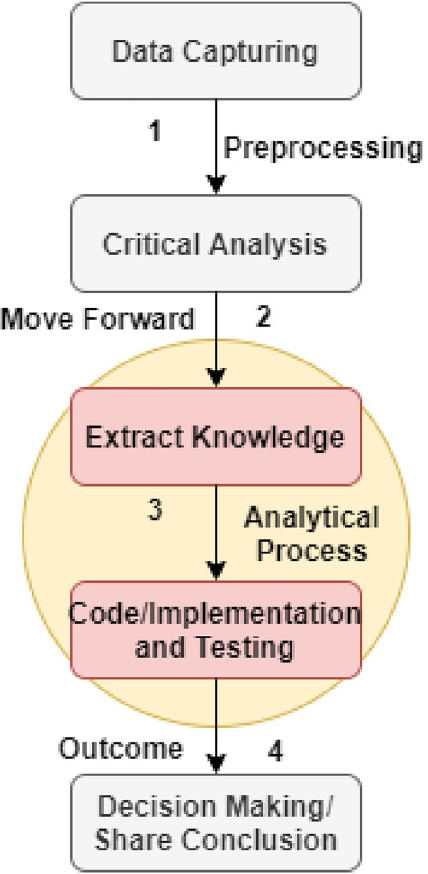
Figure 1. The current process of SMEs with IoT for data management and decision